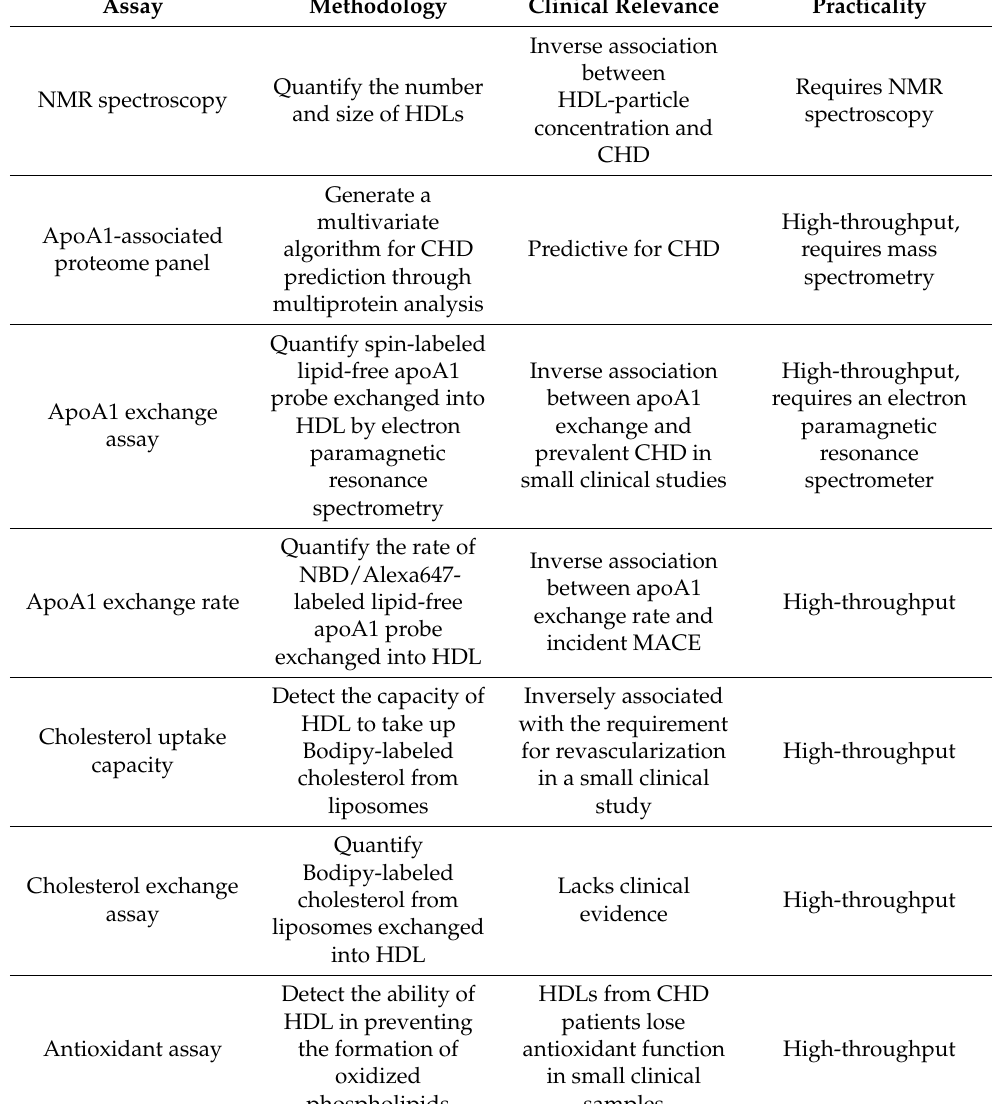
Table 2. Cell-free HDL function